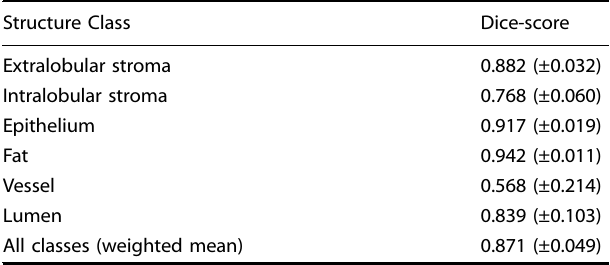
Table 1. Structure segmentation Dice-scores: Dice-scores of the structure classes on the held-out test set of 20 slides.